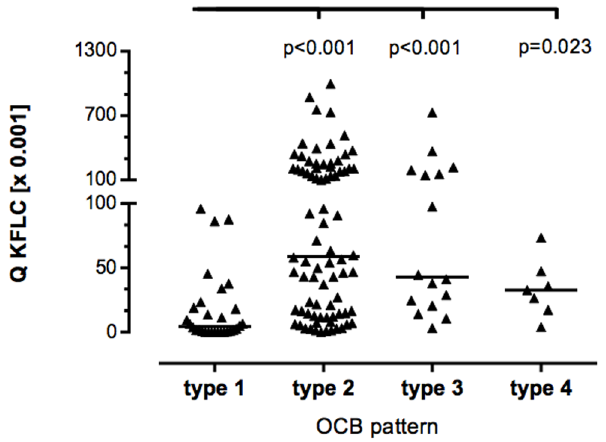
Figure 4. CSF-serum ratio of KFLC (Q KFLC) among different oligoclonal IgG band patterns. There are five classic patterns of oligoclonal bands [48] (type 1, no bands in CSF and serum; type 2, oligoclonal IgG bands in CSF but not in serum, indicative of intrathecal IgG synthesis; type 3, oligoclonal bands in CSF plus identical oligoclonal bands in serum and CSF, indicative of intrathecal IgG synthesis; type 4, identical pattern of oligoclonal bands in CSF and serum. There was no patient with type 5 (identical patterns of monoclonal bands in CSF and serum) in the study. Horizontal solid line indicates median, Kruskal- Wallis test among groups revealed a significant difference (p , 0.001), significant P-values for pairwise comparisons (Mann-Whitney U test) are